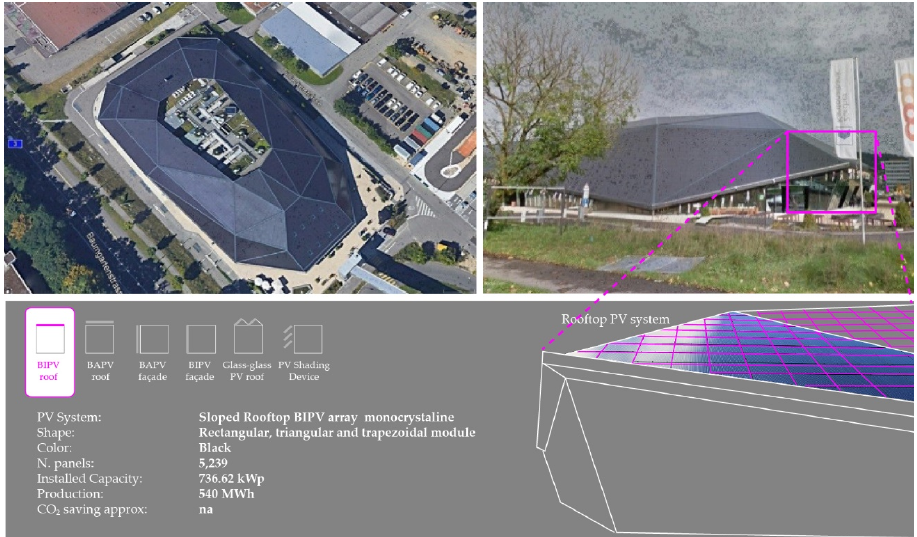
Figure 11. Umwelt Arena (a top and elevation views. Source: Google Earth, Google 2020, GeoBasis-DE/BKG 2020) ( on the top ); Integration and characteristics of PV systems ( on the bottom ).